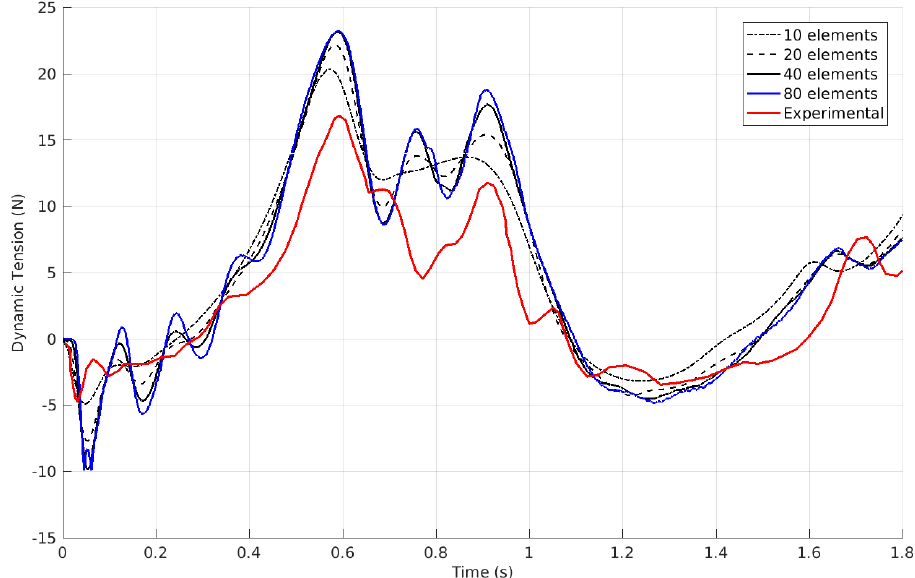
Figure 13. Numerical results for different number of nodes compared with experimental results.